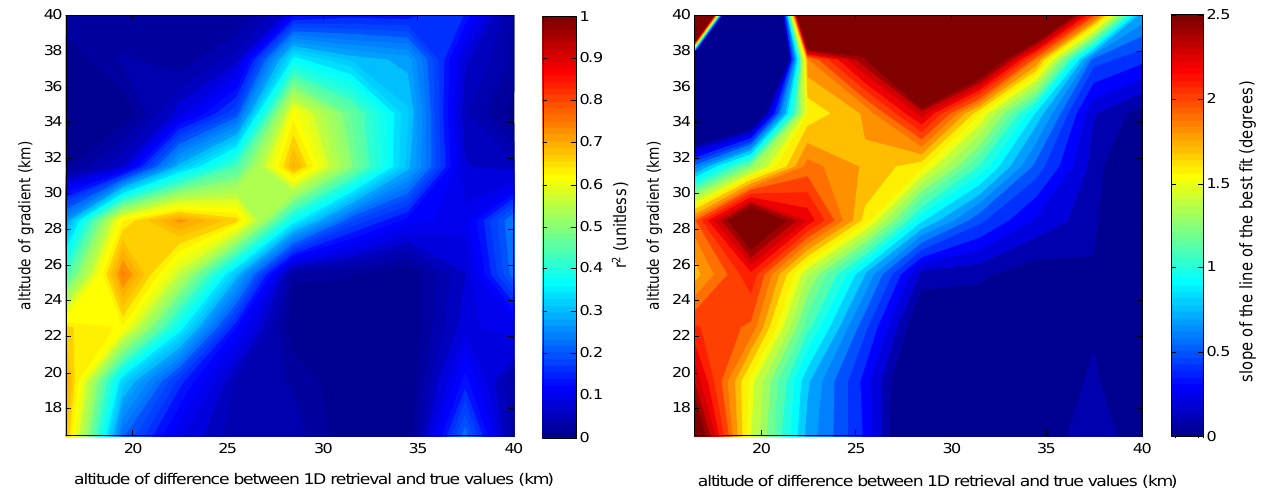
Fig. 16. Same as Fig. 9 but for simulated data for 15 December 2007. The differences are calculated between the 1-D and true (simulated) data, the gradient is obtained from the true (simulated) data.